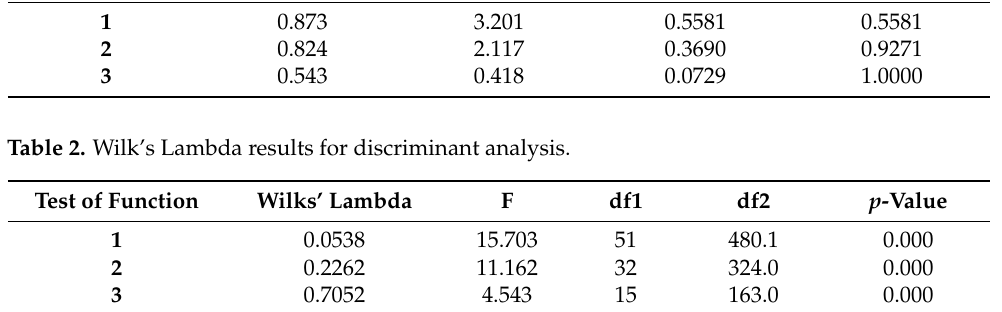
Table 2. Wilk’s Lambda results for discriminant analysis.